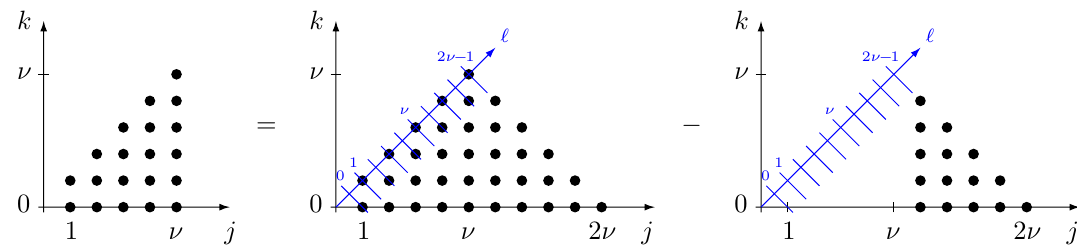
Figure 5 . Rewriting the double sum of eq. (A.4) by adding and subtracting a suitable ( j, k ) -region. On the right-hand side, we have also indicated the new summation variable ‘ that is used instead of j in eq.